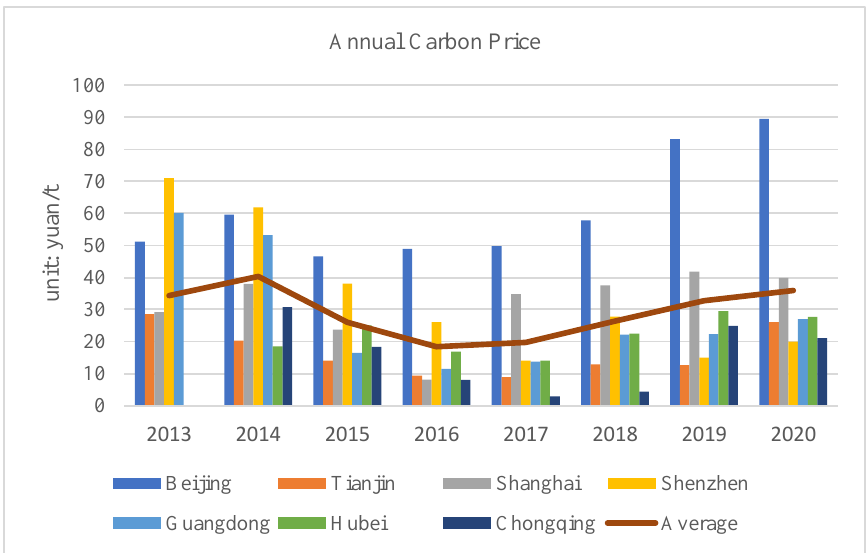
Figure 2. The average annual carbon price for all seven carbon pilots.